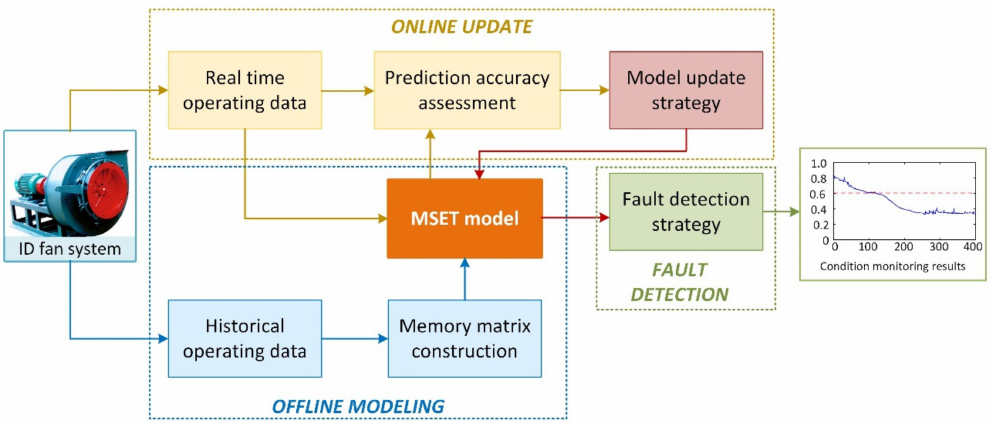
Figure 1. Framework of the adaptive early fault detection